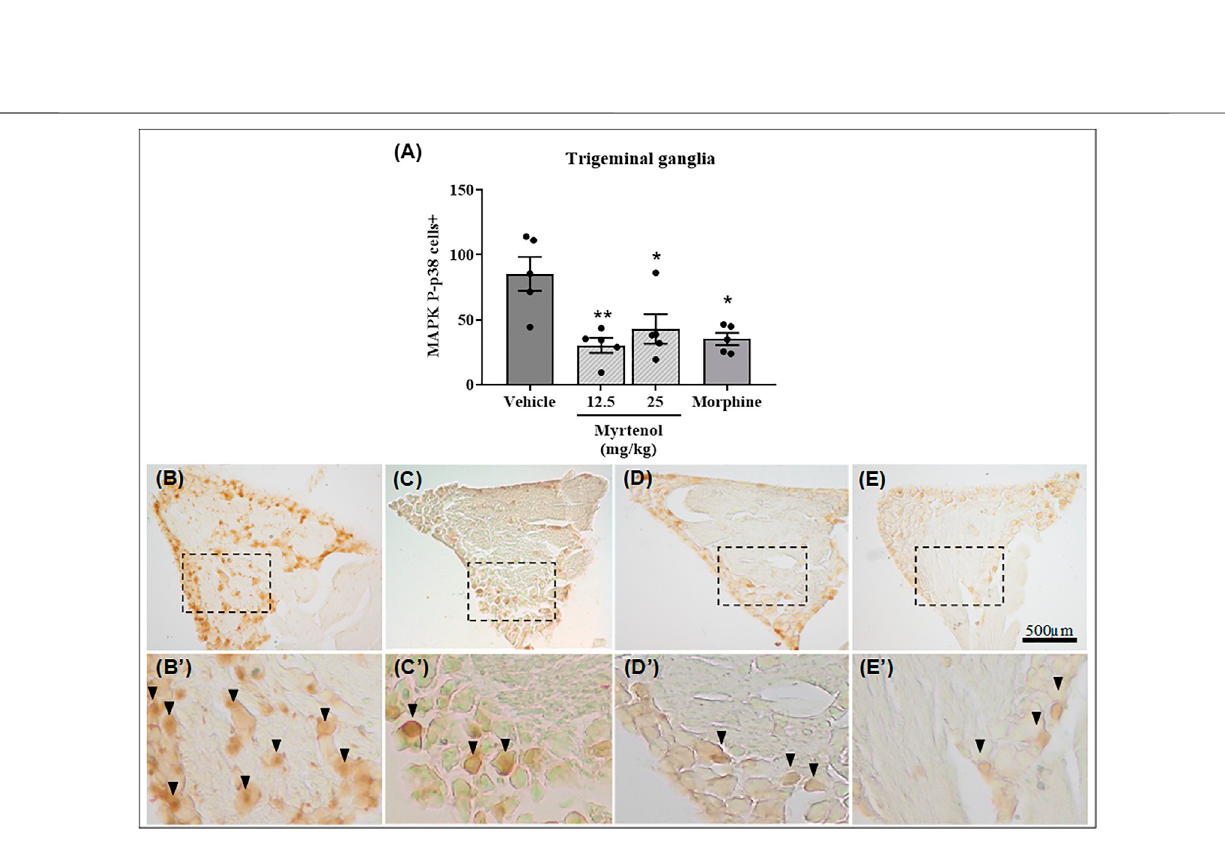
FIGURE 2 | Myrtenol reduces phosphorylated p38-MAPK staining in trigeminal ganglia of mice submitted to orofacial formalin test. (A) : Each bar represents the mean±SEMofthenumberofthepositivecellsbyphosphorylatedp38-MAPKstaining(n=5).ANOVA[F(3,16)=7.19, p =0.0028]followedbyTukey´stest,* p < 0.05or ** p < 0.01 vs. vehicle group. (B – E) : representative images (40 x) of vehicle + formalin (B) , myrtenol (12.5 mg/kg) + formalin (C) , myrtenol (25 mg/kg) + formalin (D) and morphine (5 mg/kg) + formalin (E) groups. Panels B ′ -E ’ : higher magni fi cation (100x) of dotted areas from (B – E) ,